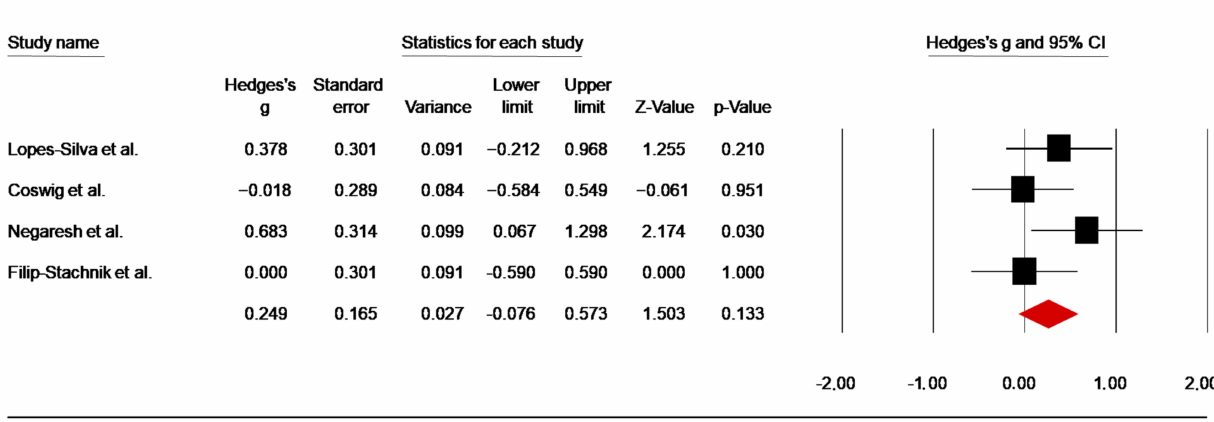
Figure 11. Forest plot of the effect of caffeine intake on end-of-fight HR